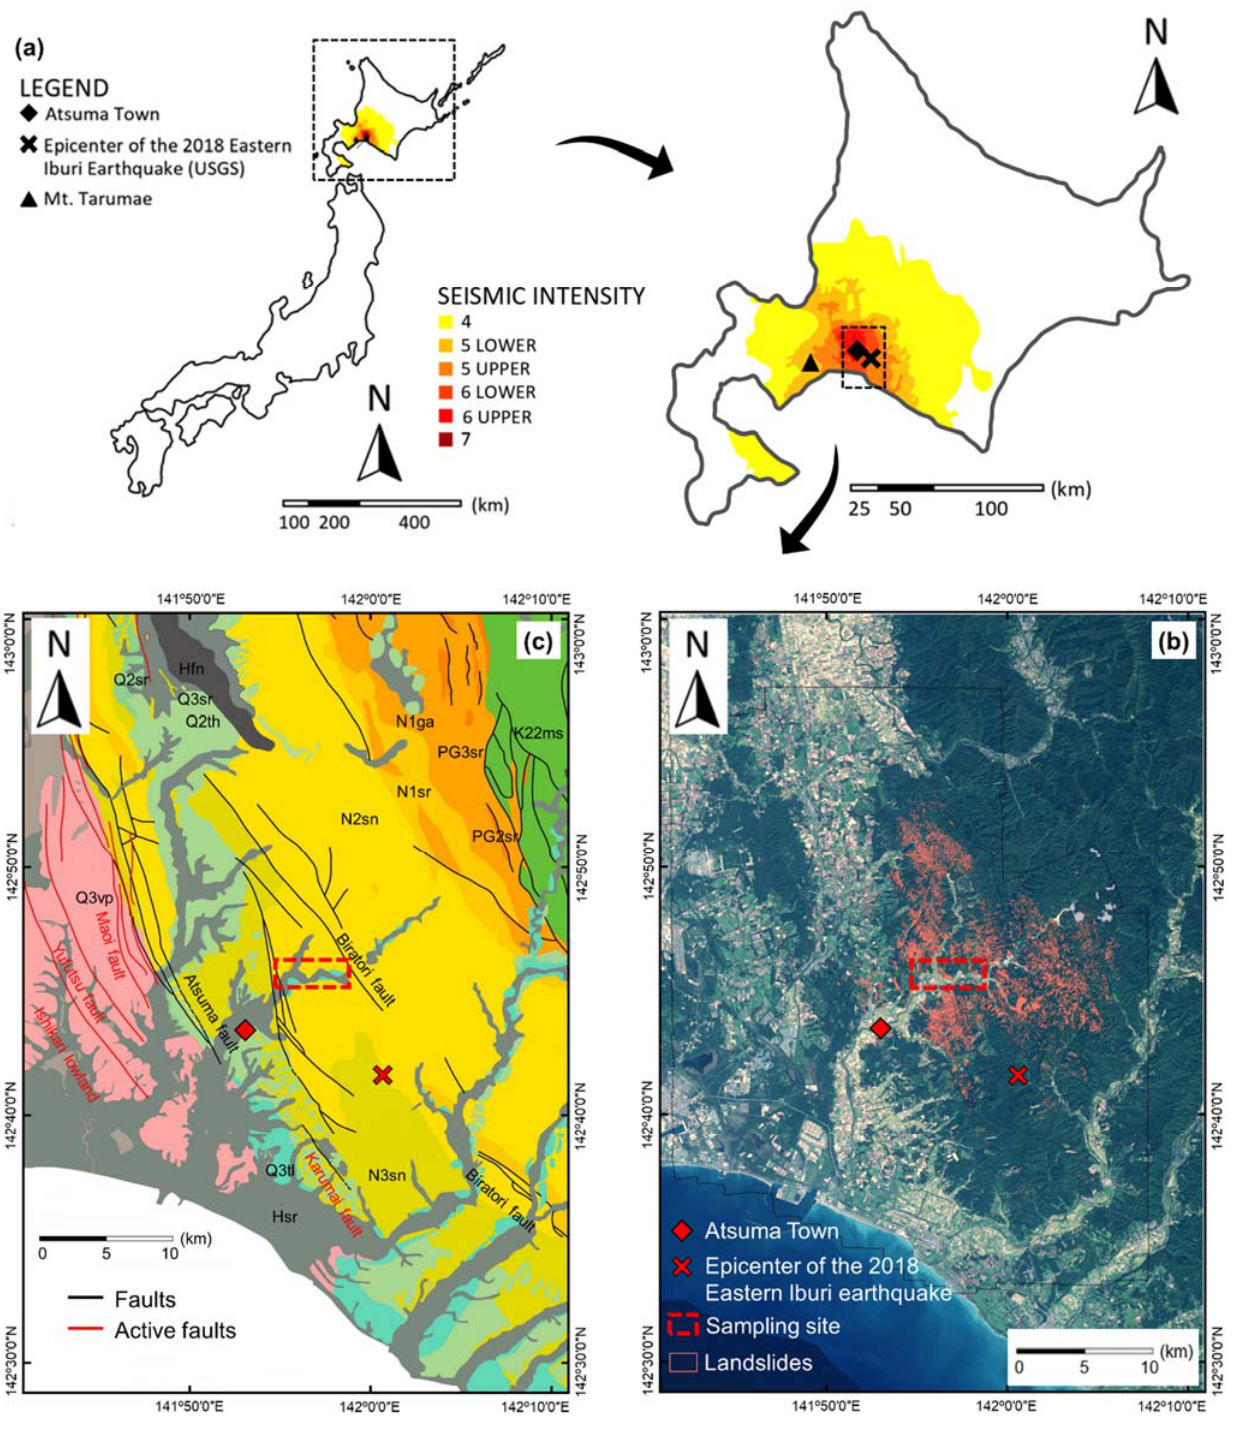
Figure 1. ( a ) Distribution of seismic intensity during the 2018 Eastern Iburi earthquake, Hokkaido, Japan (Modified from Japan Meteorological Agency [33]); ( b ) Landslide distribution provided by the Geospatial Authority of Japan; ( c ) Geological settings within the area affected by landslides derived from a 1:200,000 geological map published by the Geological Survey of Japan (adapted with permission from Ref. [31]. 2019, Shuai Zhang et al.). Geological units are described in (Table 1). Red dotted box in ( b , c ) indicates location where soil samples were collected.